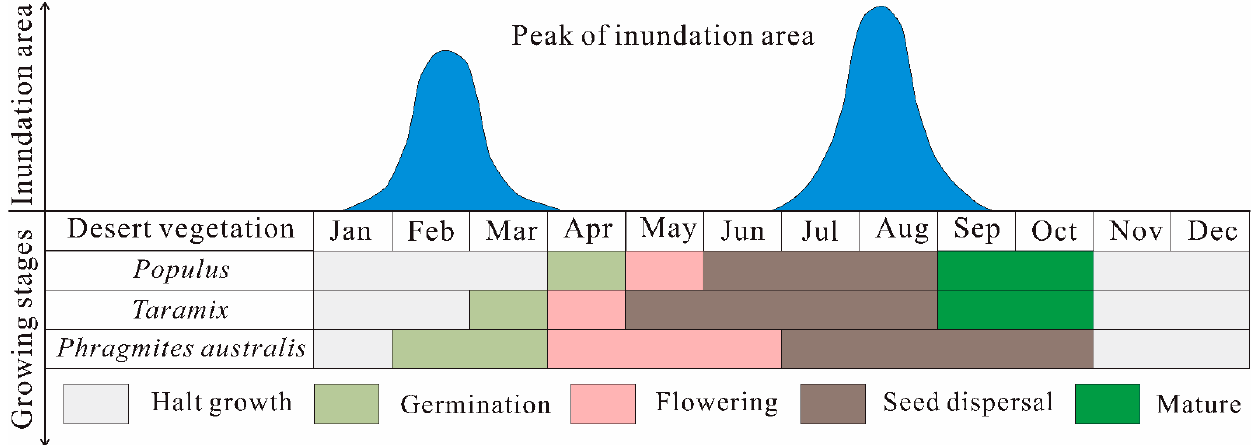
Figure 13. Peak values in inundation area and growing period of the dominant species ( Populus , Tamarix , and Phragmites australis ) in the Daliyaboyi